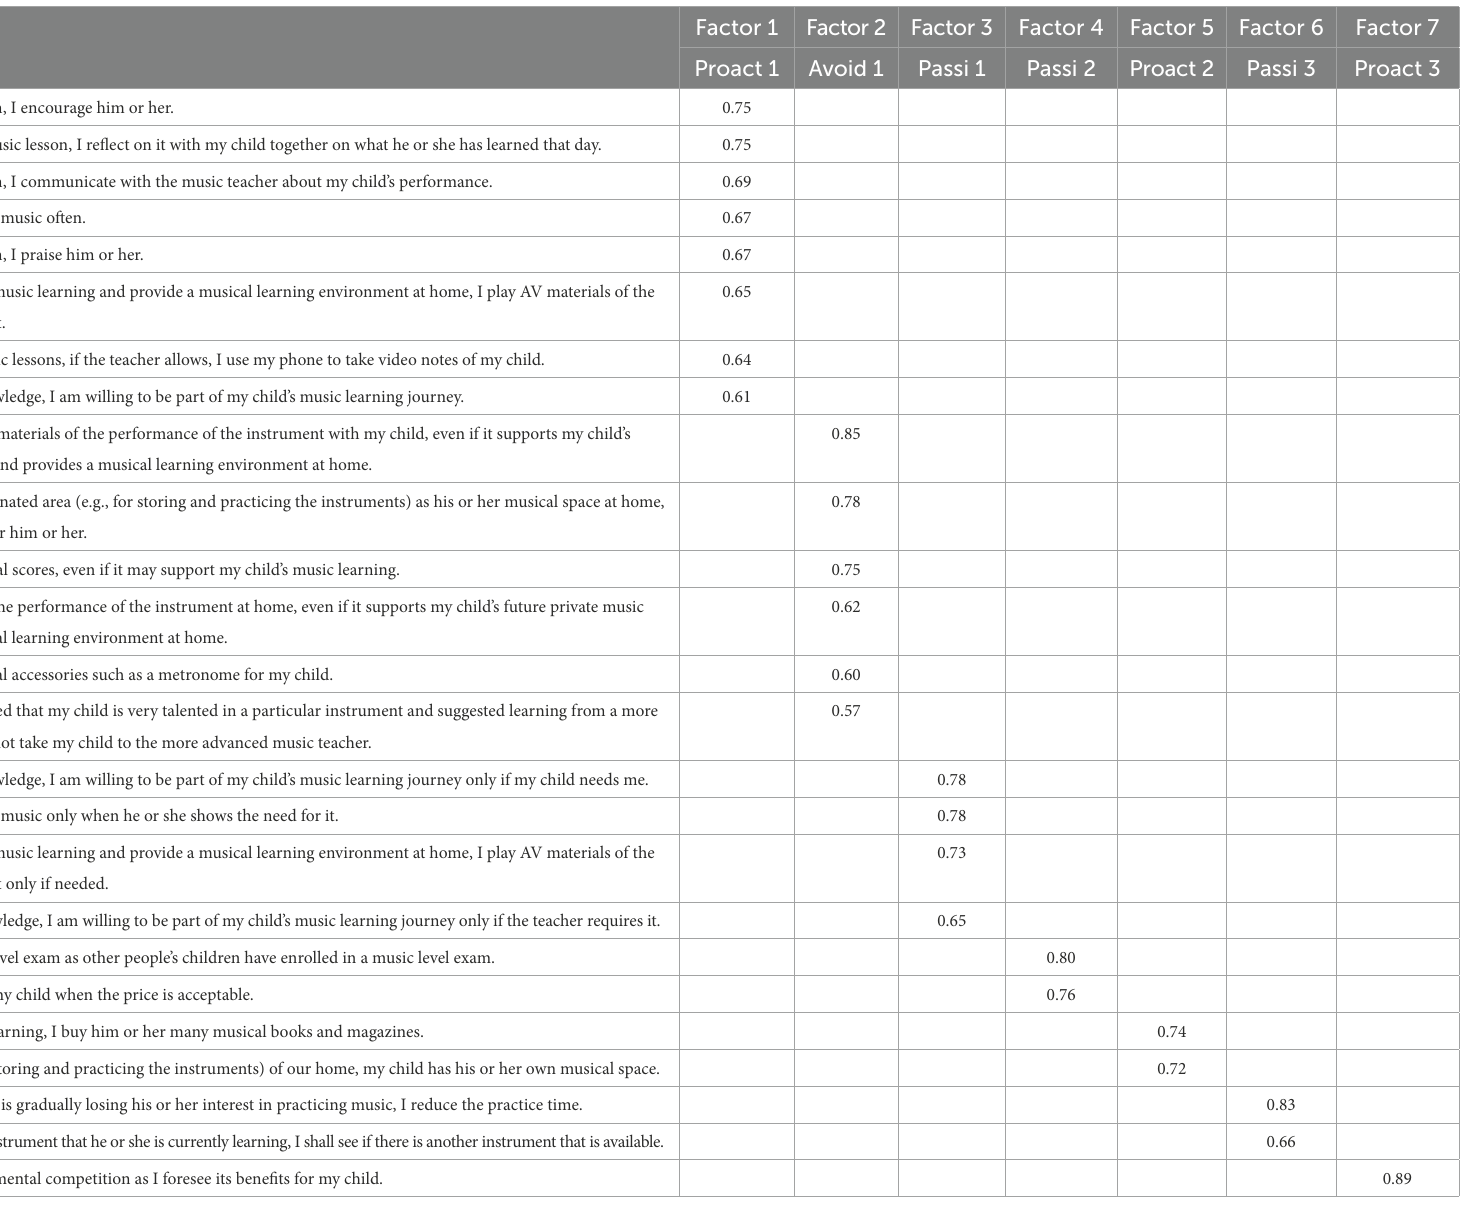
Factor 1 Factor 2 Factor 3 Factor 4 Factor 5 Factor 6 Factor 7 Proact 1 Avoid 1 Passi 1 Passi 2 Proact 2 Passi 3 Proact